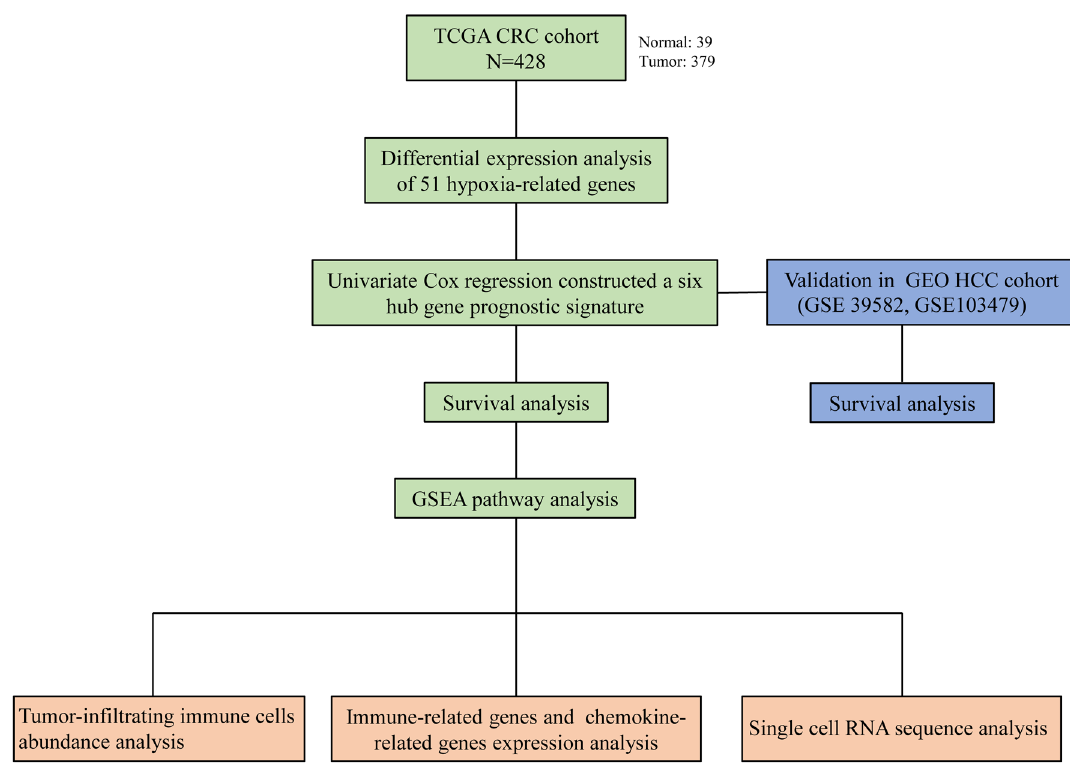
Figure 1. The study